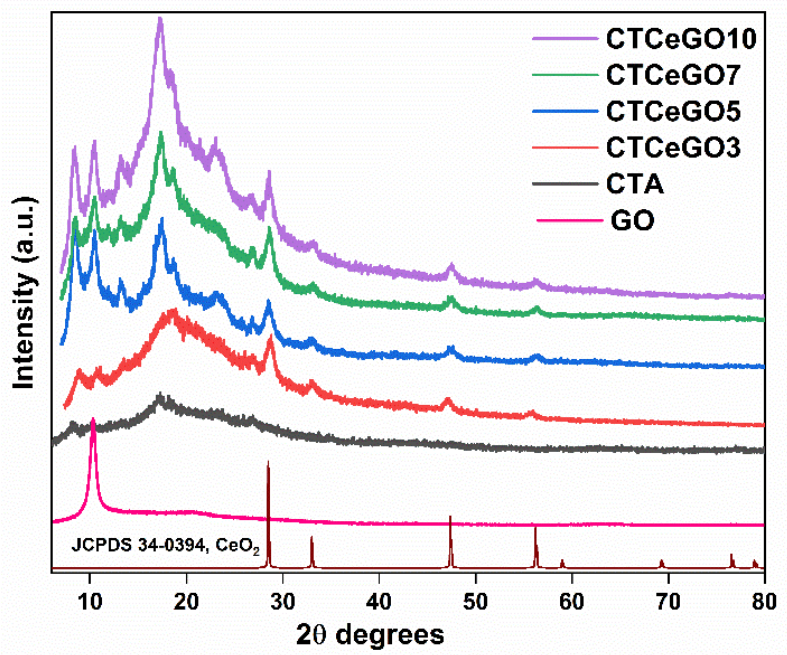
Figure 2. SEM images of the surface and their corresponding cross-section of the synthesized samples; ( A , E ) CTCeGO3,